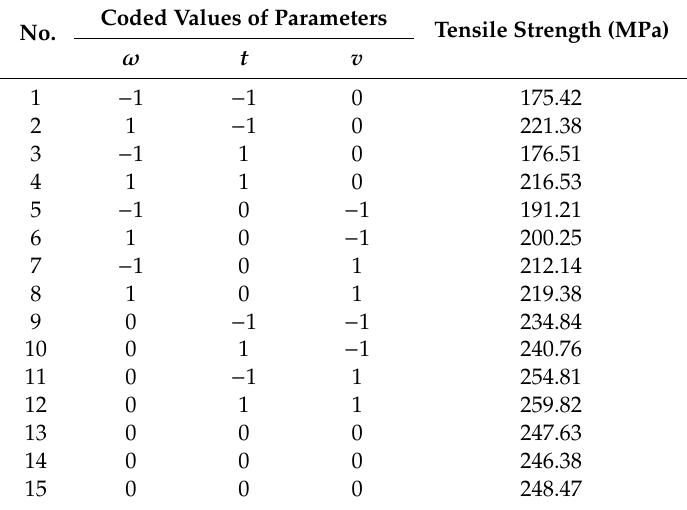
Table 4. Design layout including experimental